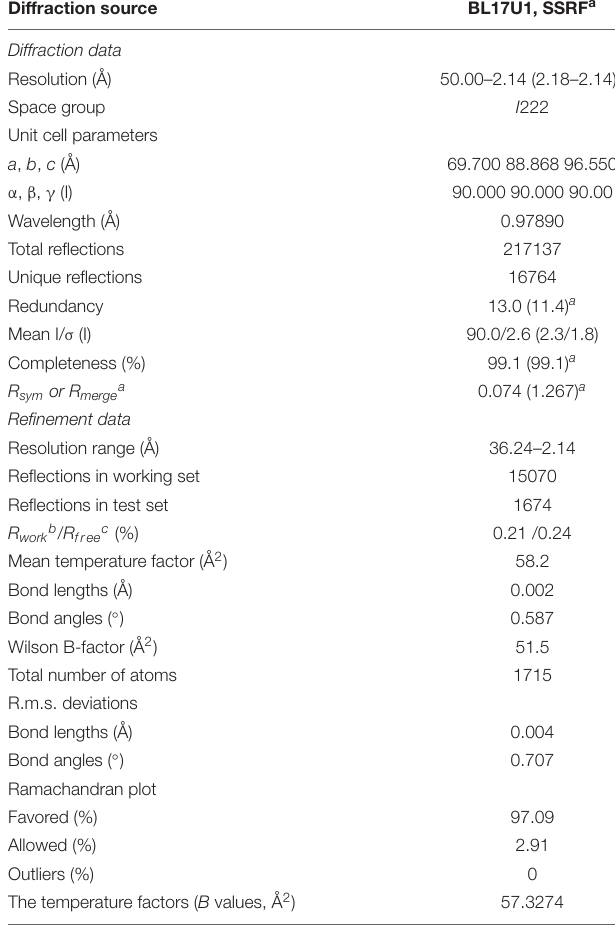
TABLE 1 | Dissociation constant and thermodynamic data during the Hsp90 N -SNX-2112 binding process at 25 ◦ C. Items Thermodynamic data (mean ± SD, n = 4)